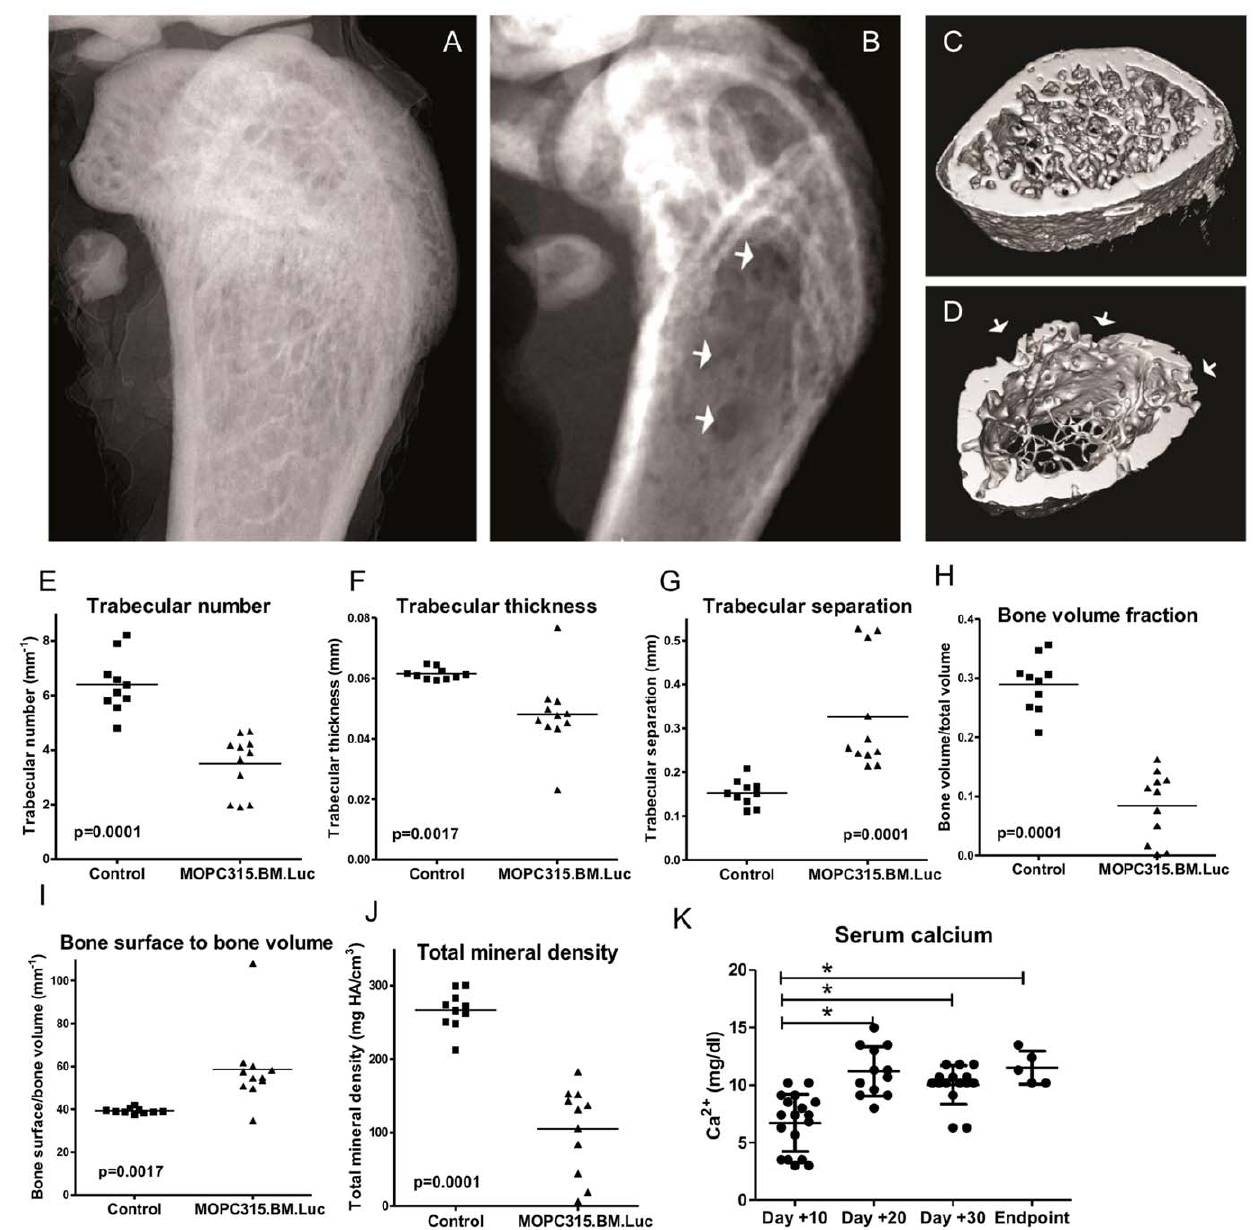
Figure 7. Osteolysis induced by MOPC315.BM.Luc cells. Transmission X-rays of distal femurs of NSG mice injected with either RPMI 1640 (A) or MOPC315.BM.Luc (expressing a doxycycline inducible non-functional control shRNA) (B) show extensive osteolytic lesions in the latter (white arrows). Similarly, m CT 3D reconstruction of the respective NSG femurs demonstrate reduced wall thickness (white arrows) and trabecular structures in bone marrow infiltrated by MOPC315.BM.Luc (expressing a doxycycline inducible non-functional control shRNA) (D) compared to age-matched controls (C). (E–J) Quantification of bone structure changes in BALB/c mice 5–8 weeks after injection of MOPC315.BM.Luc (5 6 10 5 cells) and in age-matched controls. (K) Measurement of Ca 2 + in serum of BALB/c mice at various time points after injection with MOPC315.BM. *p ,